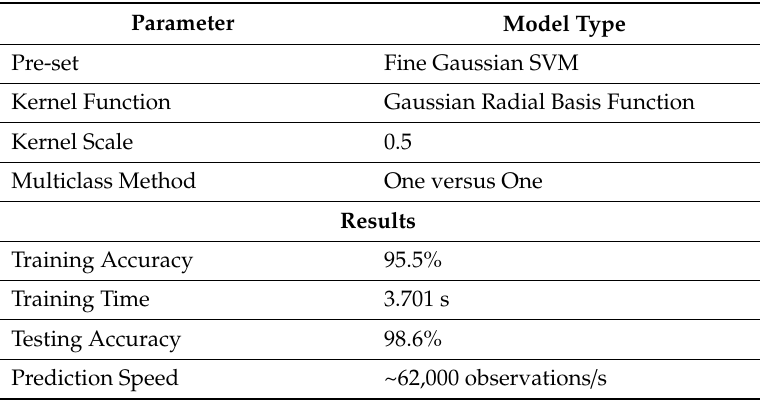
Table 4. Classifier parameters and